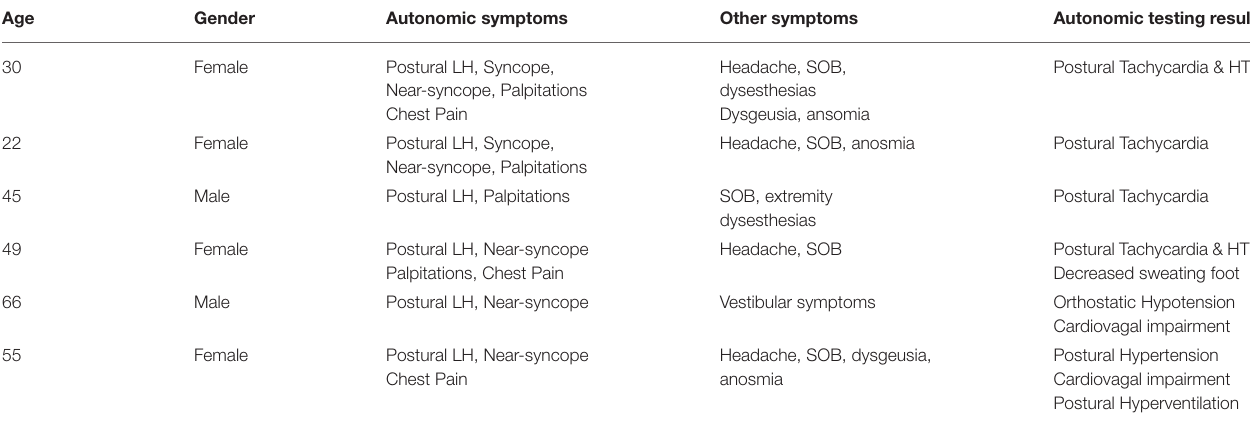
TABLE 1 | Patient demographics and features—COVID-19 dysautonomia.